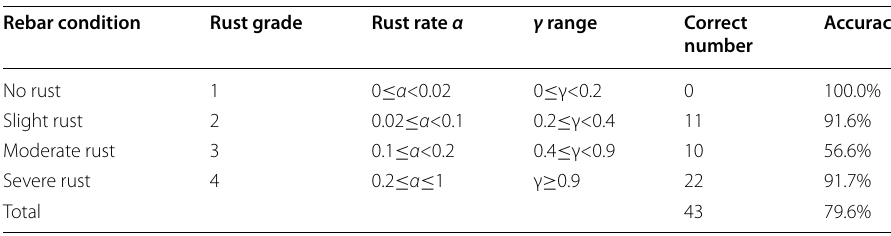
Table 8 Accuracy of model NBC-II